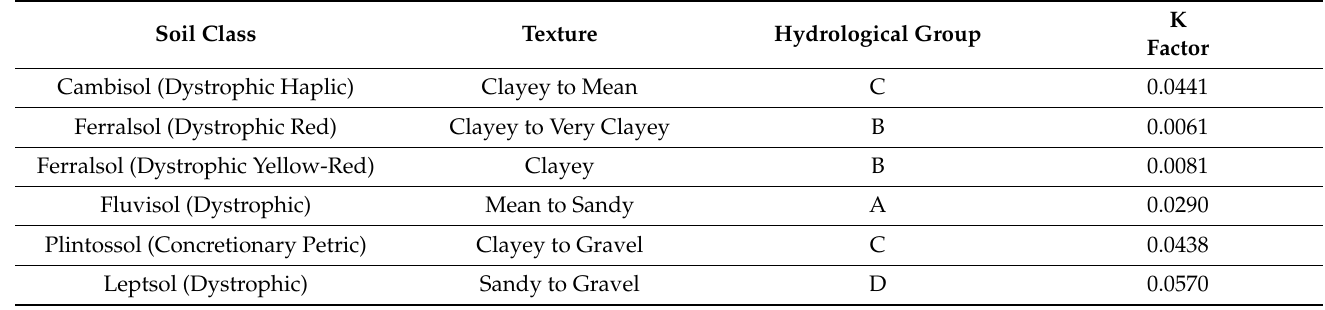
Table 1. Soil classes, texture, and their correspondence in Hydrological Groups and K factor. Source: adapted by authors from